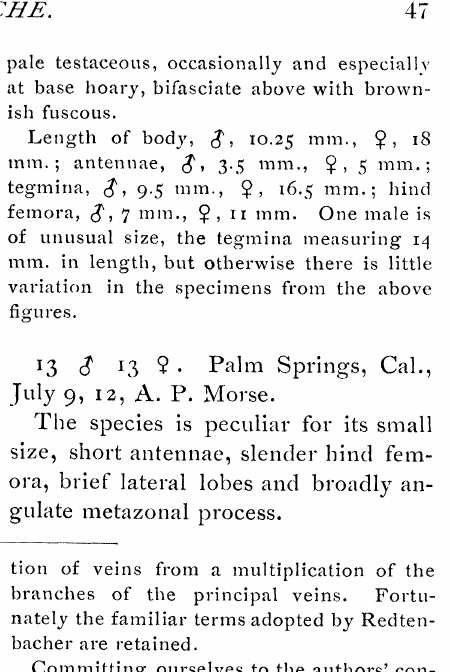
tion of veins from a multiplication of the branches of the principal